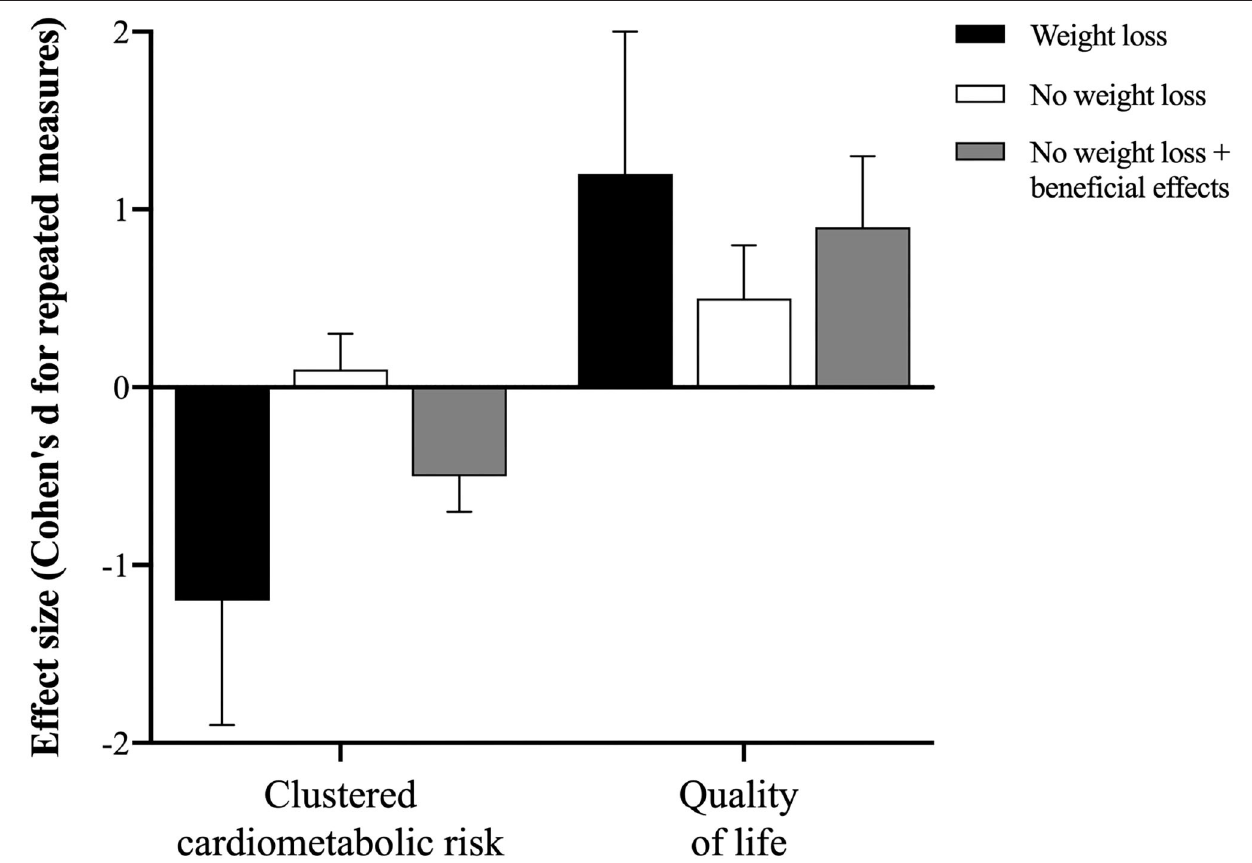
FIGURE 2 | Effect size (Cohen’s d for repeated measures) for clustered cardiometabolic risk, and quality of life in participants who lost weight (“weight loss”; n = 11), those who maintained or gained body weight (“no weight loss”, n = 44), and those who maintained or gained body weight and showed some improvement in cardiometabolic profile or quality of life (“no weight loss + beneficial effect”, n = 15 and 32, respectively). This overview picture supports the conclusion that intervention-induced weight loss induces greater improvements in cardiometabolic health; however, improvements in health and wellness may take place in the absence of weight loss or even weight gain, although the magnitude of the benefits is clearly lower, as compared to that of the first scenario.